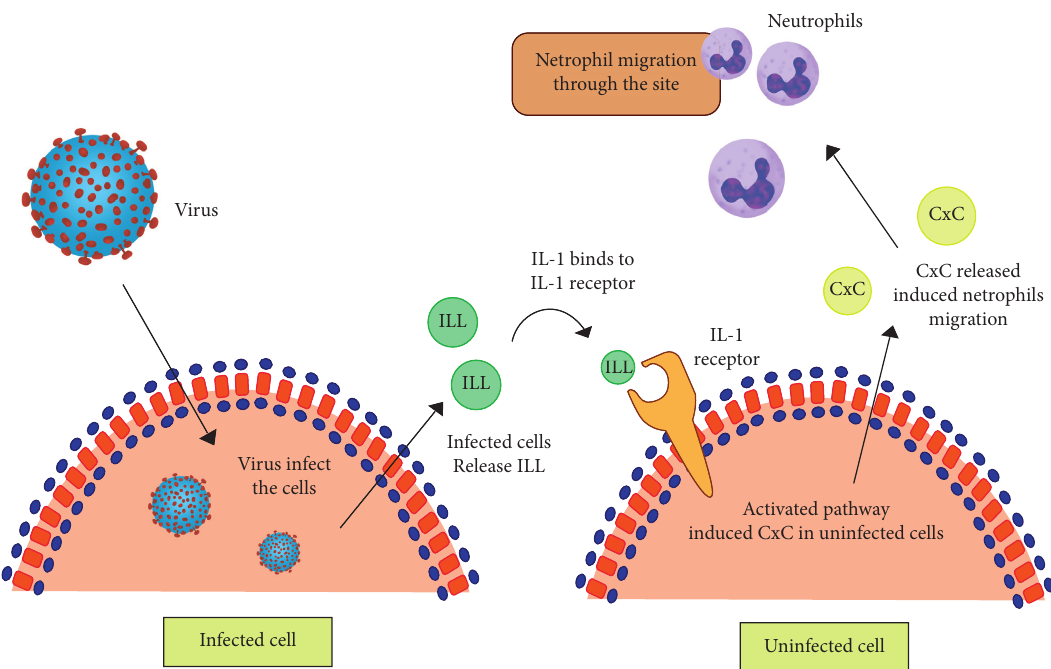
Figure 1: Neutrophils recruitment during RCoV infection. RCoV infects AT1 cells, induces secretion of IL-1, induces CXC in uninfected cells, and triggers neutrophils recruitment (adaptation from Miura et al.